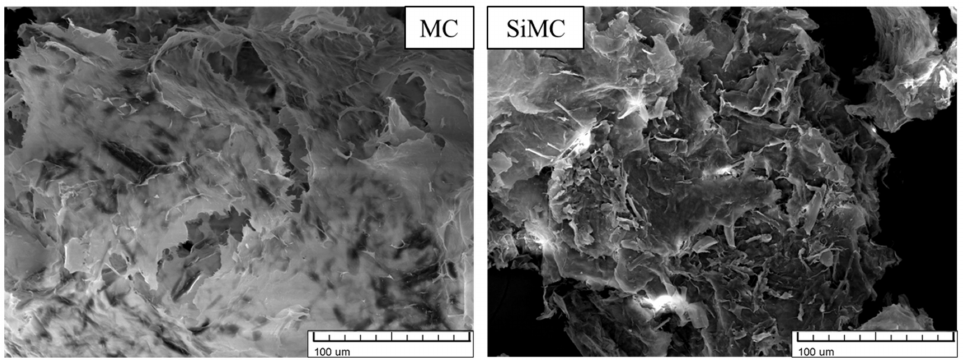
Figure 7. SEM images of microcellulose (MC) and silanized microcellulose (SiMC). The surface of untreated SD particles was smoother (see Figure 5), but the surface